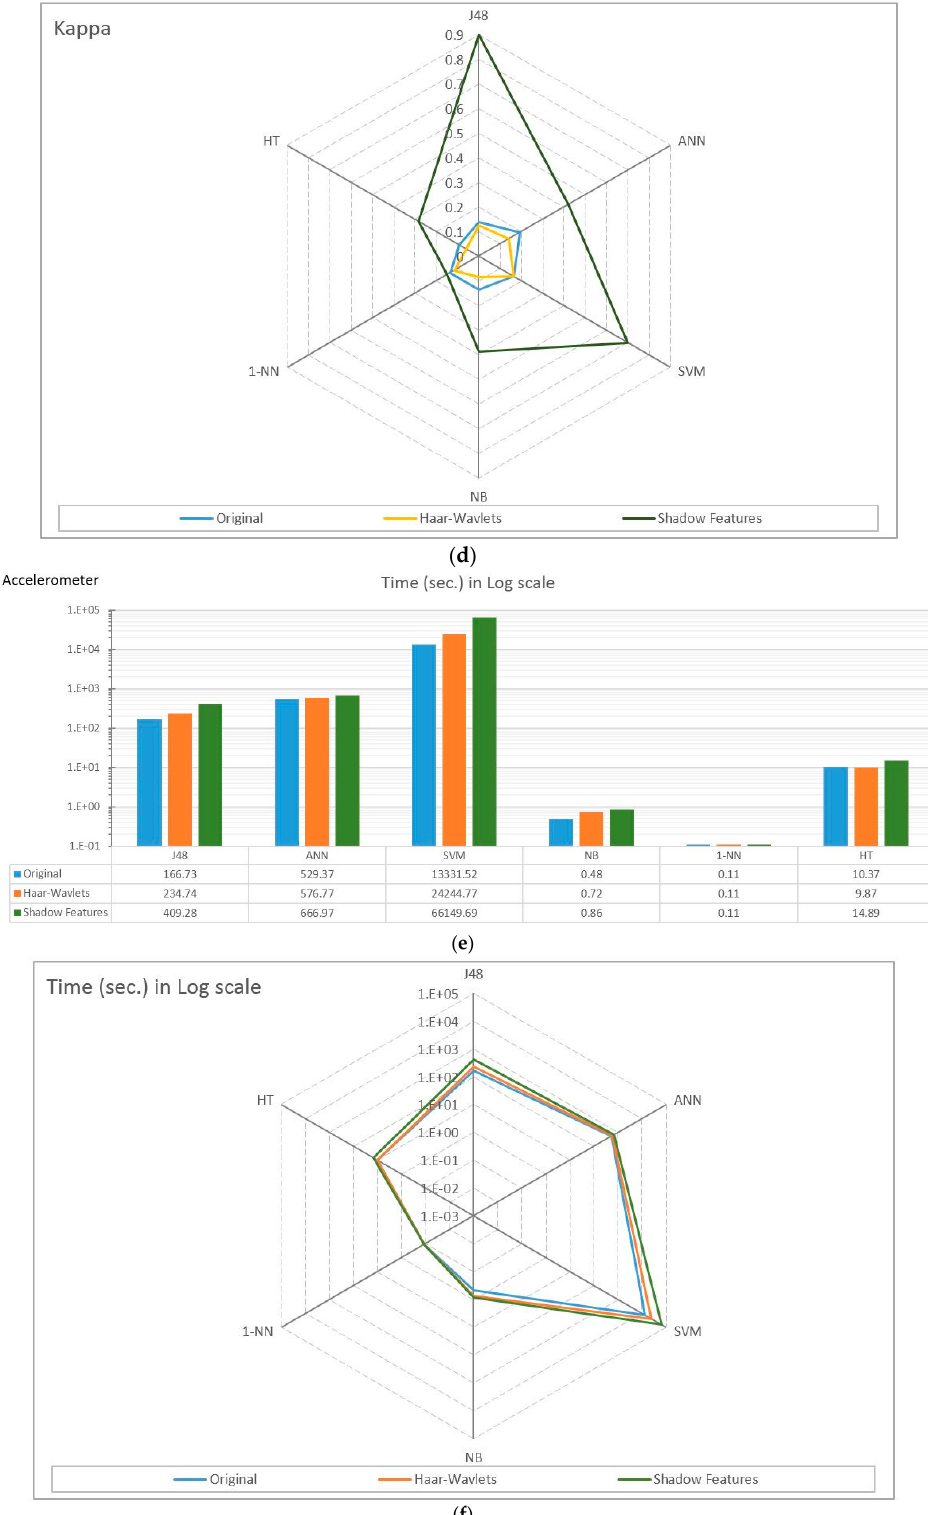
Figure 10. Major performance indicators of classifiers in accelerometer data with different pre-processing strategies based on ( a , b ) F-measure of accelerator; ( c , d ) Kappa values of accelerator, and ( e , f ) Time (sec) in Log